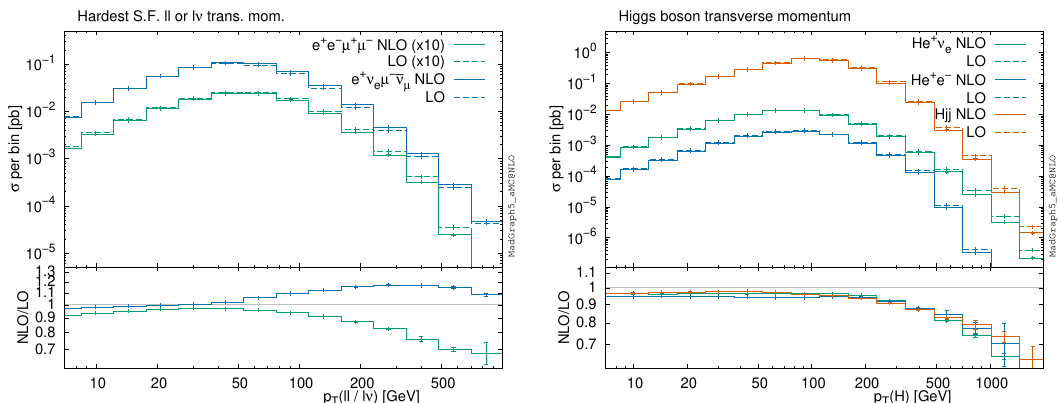
Figure 7. Transverse momentum of the hardest same-(cid:13)avour dressed-lepton pair in the processes of eq. (6.17) (left panel), and Higgs transverse momentum in the processes of eq. (6.18) (right panel).